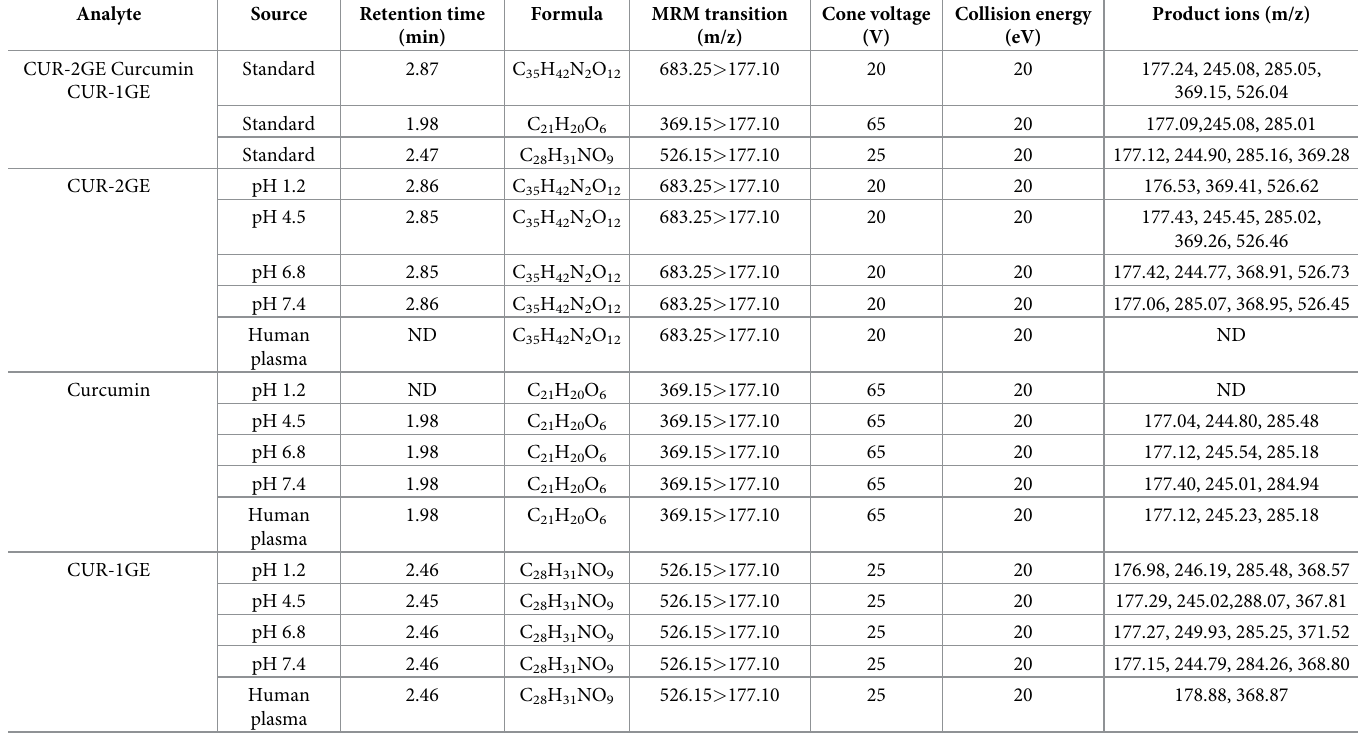
Table 3. UPLC-MS/MS results of CUR-2GE and its hydrolytic products after incubation.